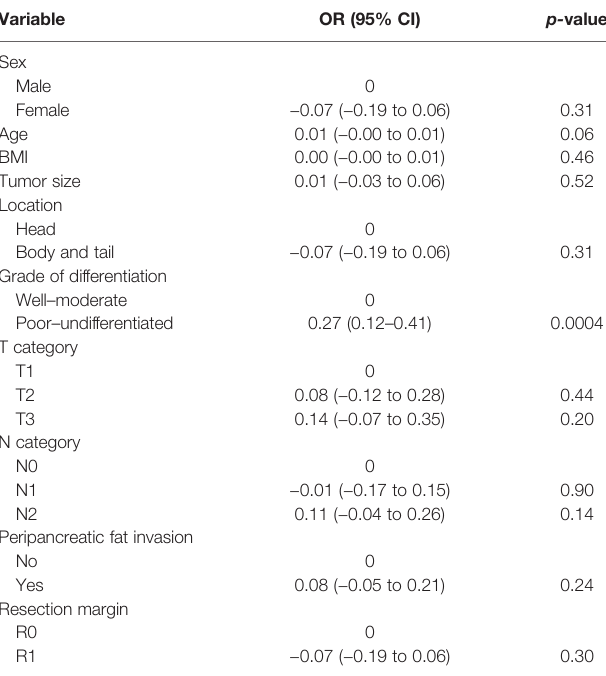
TABLE 5 | Results of the univariate analysis between all variables and the tumor budding score. Variable OR (95% CI) p-